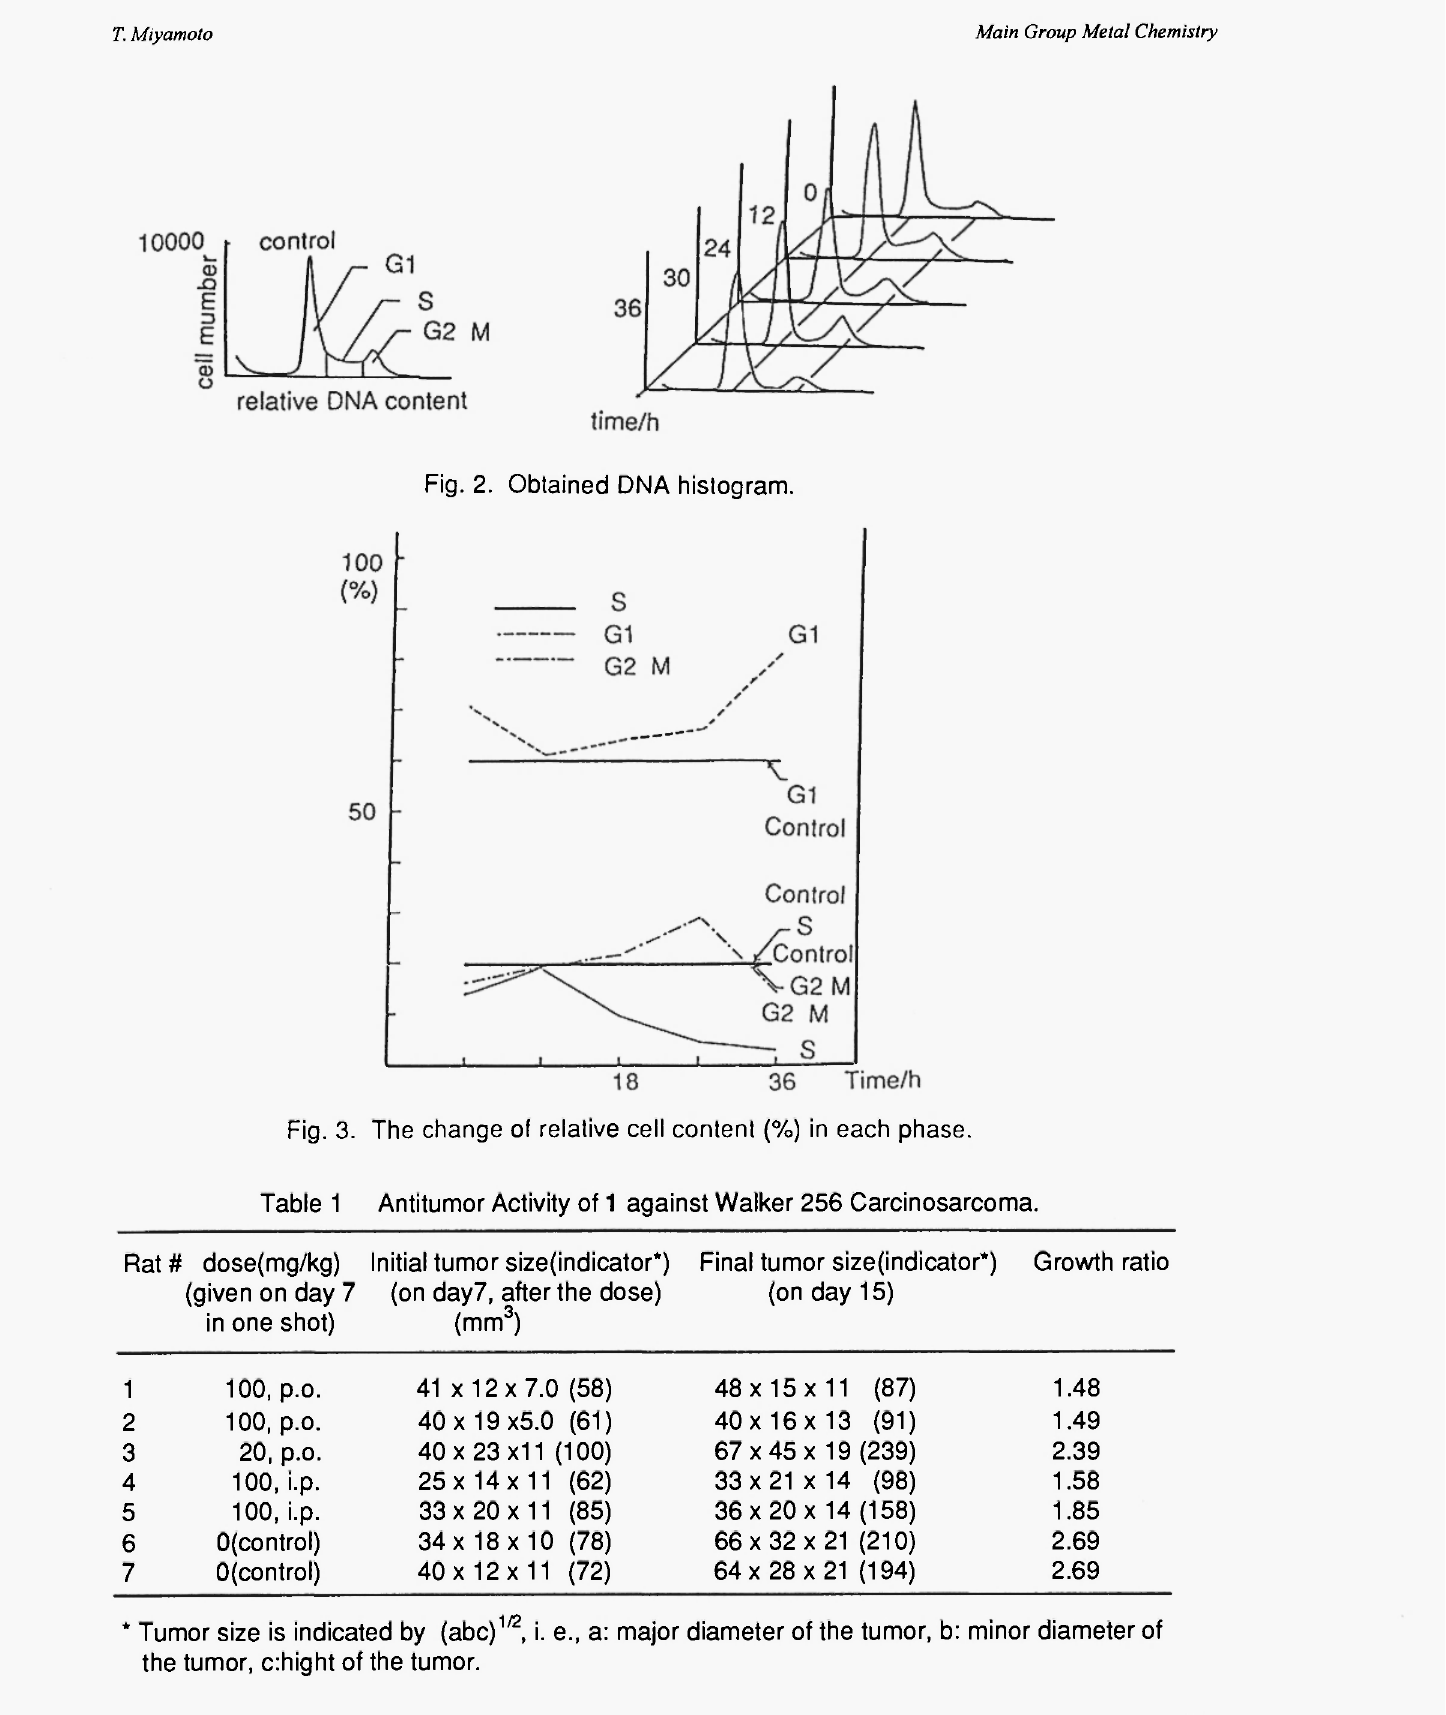
Fig. 3. The change of relative cell content (%) in each phase. Antitumor Activity of 1 against Walker 256